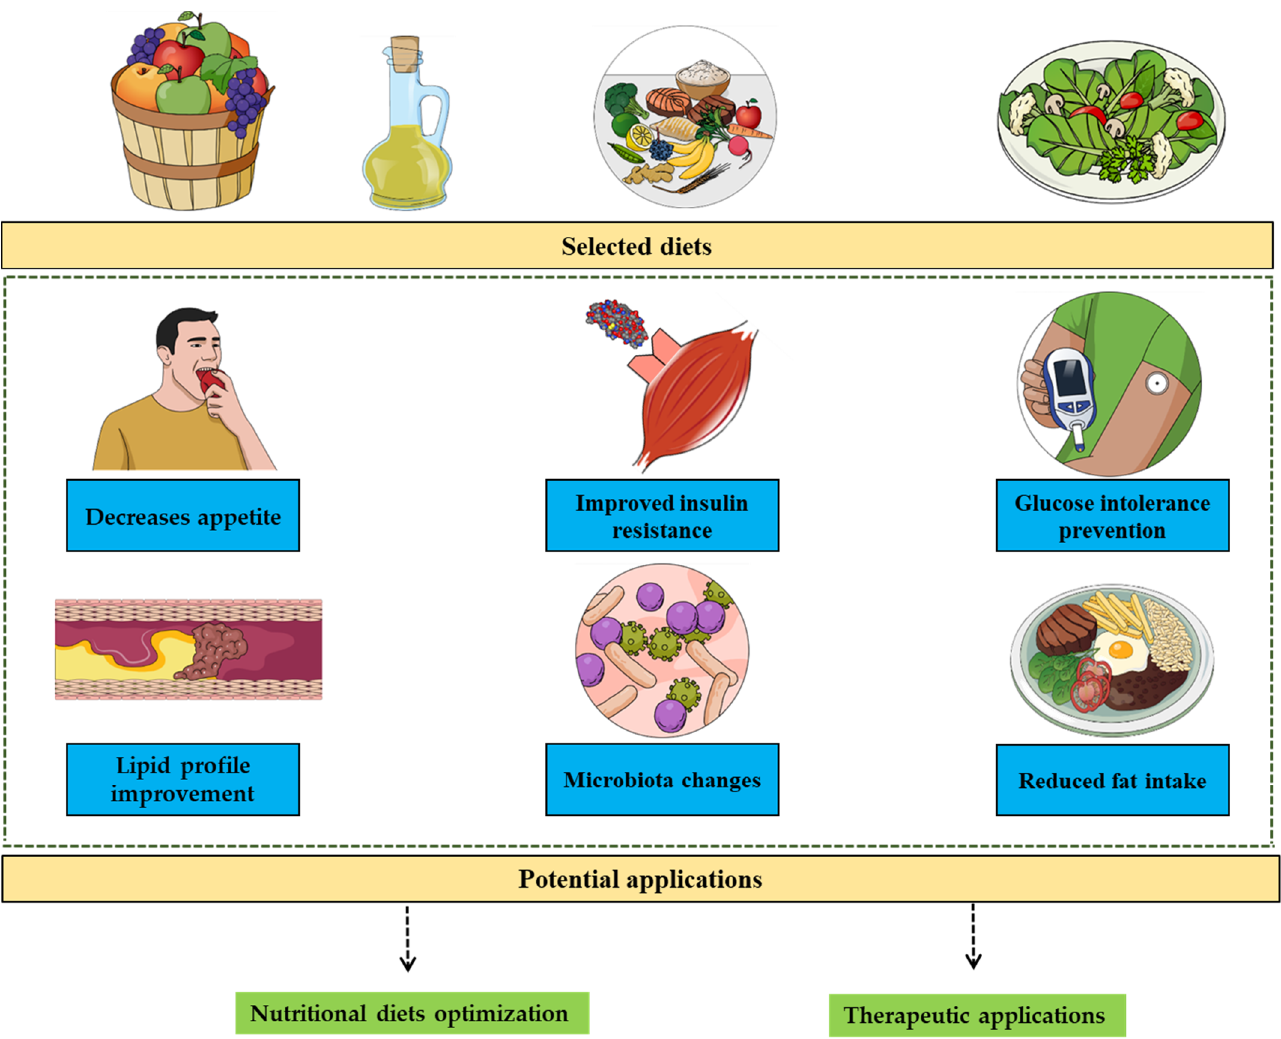
Figure 2. Indirect impacts diet has on energy metabolism. Some diets have the ability to impact the energy metabolism through insulin sensitivity improvement, appetite control, microbiota changes-related metabolic changes and improving the lipids profile. These properties are independent from the caloric intake that comes with such diets due to caloric inde- pendent-patterns.